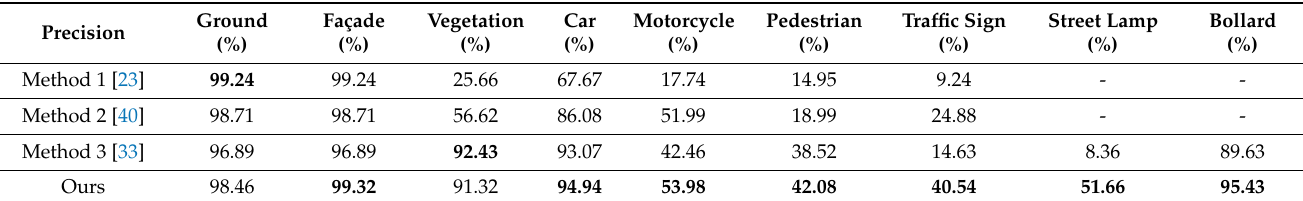
Table 6. Precision of different methods in the Paris-rue-Cassette